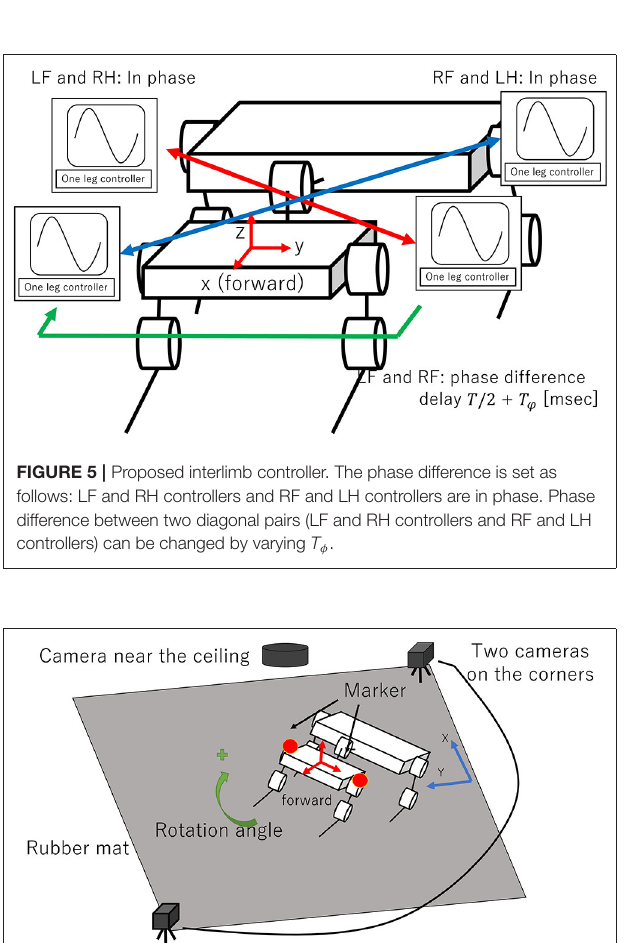
FIGURE 6 | Experimental setup.